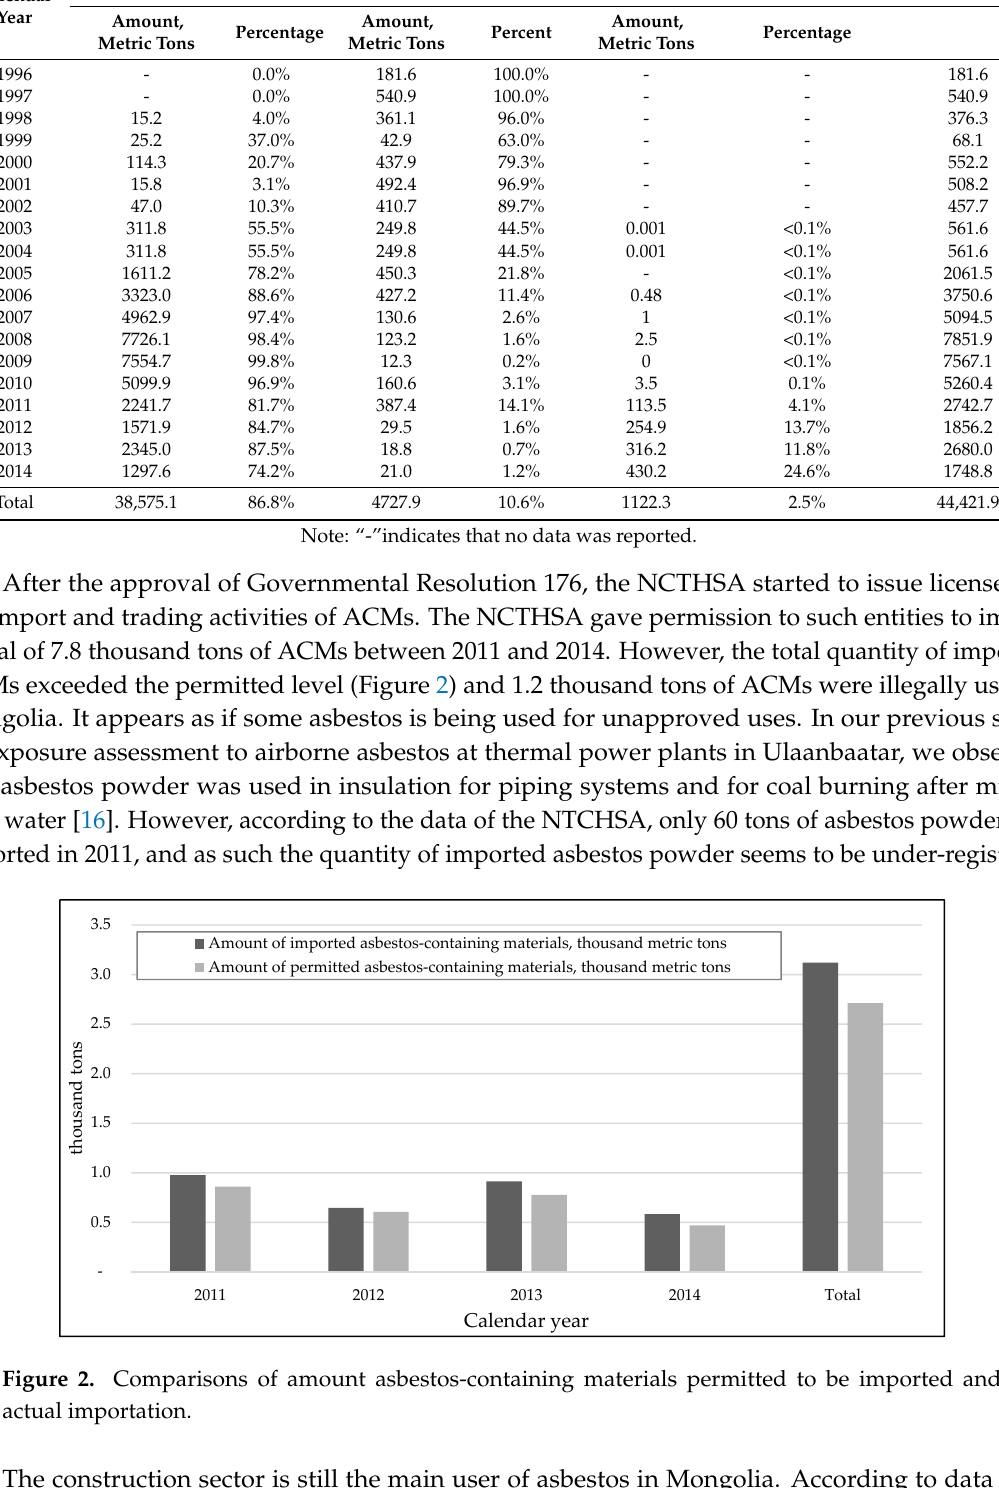
Table 1. Amount of imported asbestos-containing materials in Mongolia between 1996 and 2014.